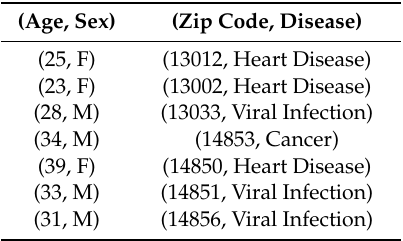
Table 5. Sliced table.